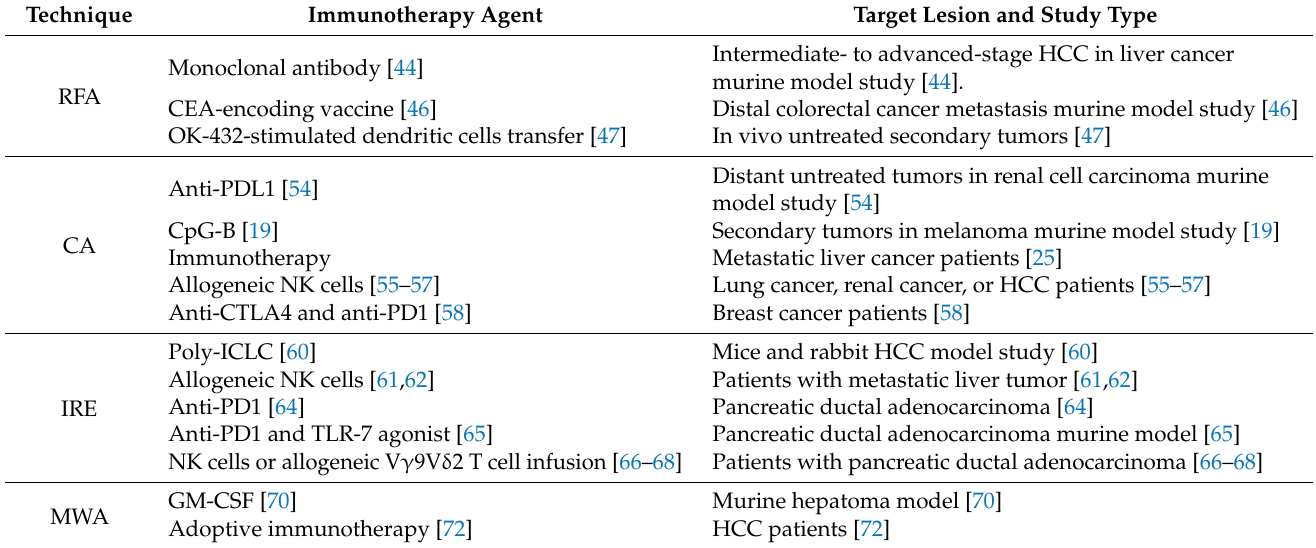
Table 2. Ablative technique, immunotherapy agents, and target